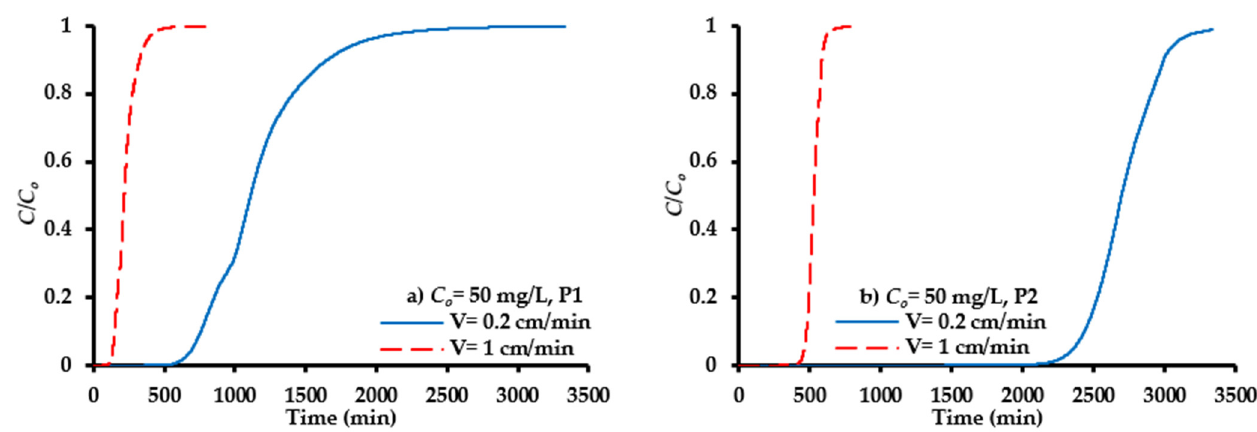
Figure 8. COMSOL prediction for propagation of SO 42 − ions front under variation of pore water velocity for ports ( a ) P1 and ( b ) P2.